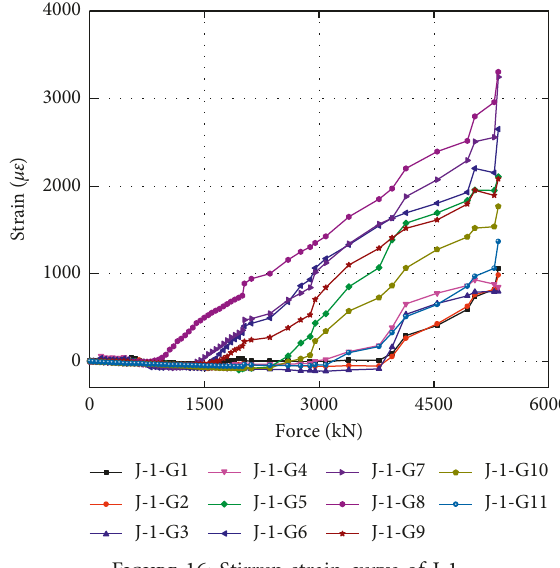
Figure 16: Stirrup strain curve of J-1.